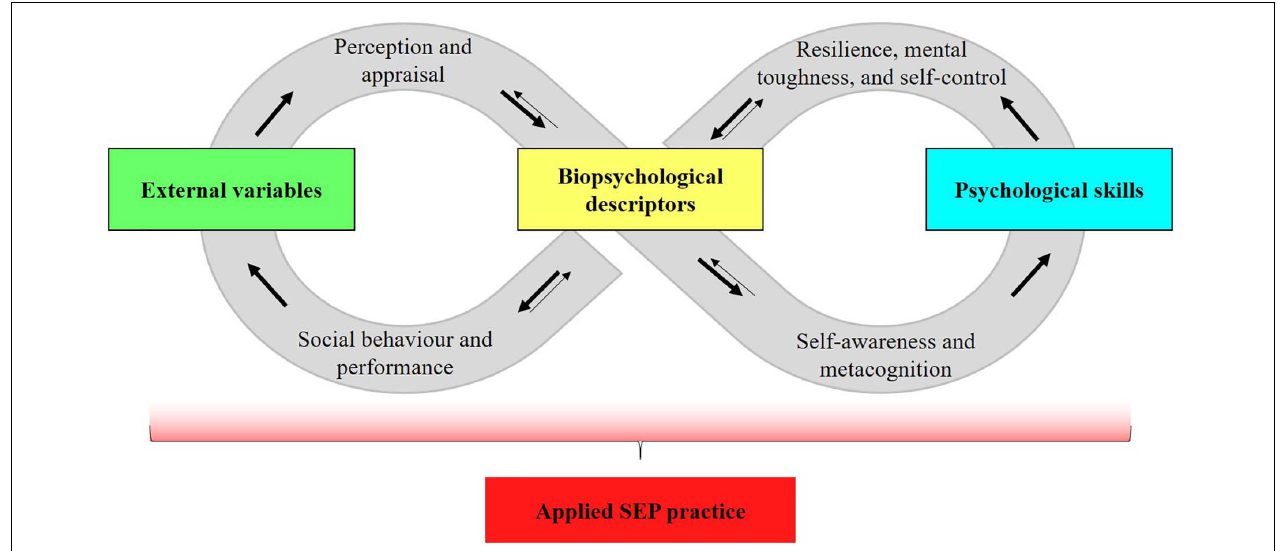
FIGURE 2 | The knowledge map of sport and exercise